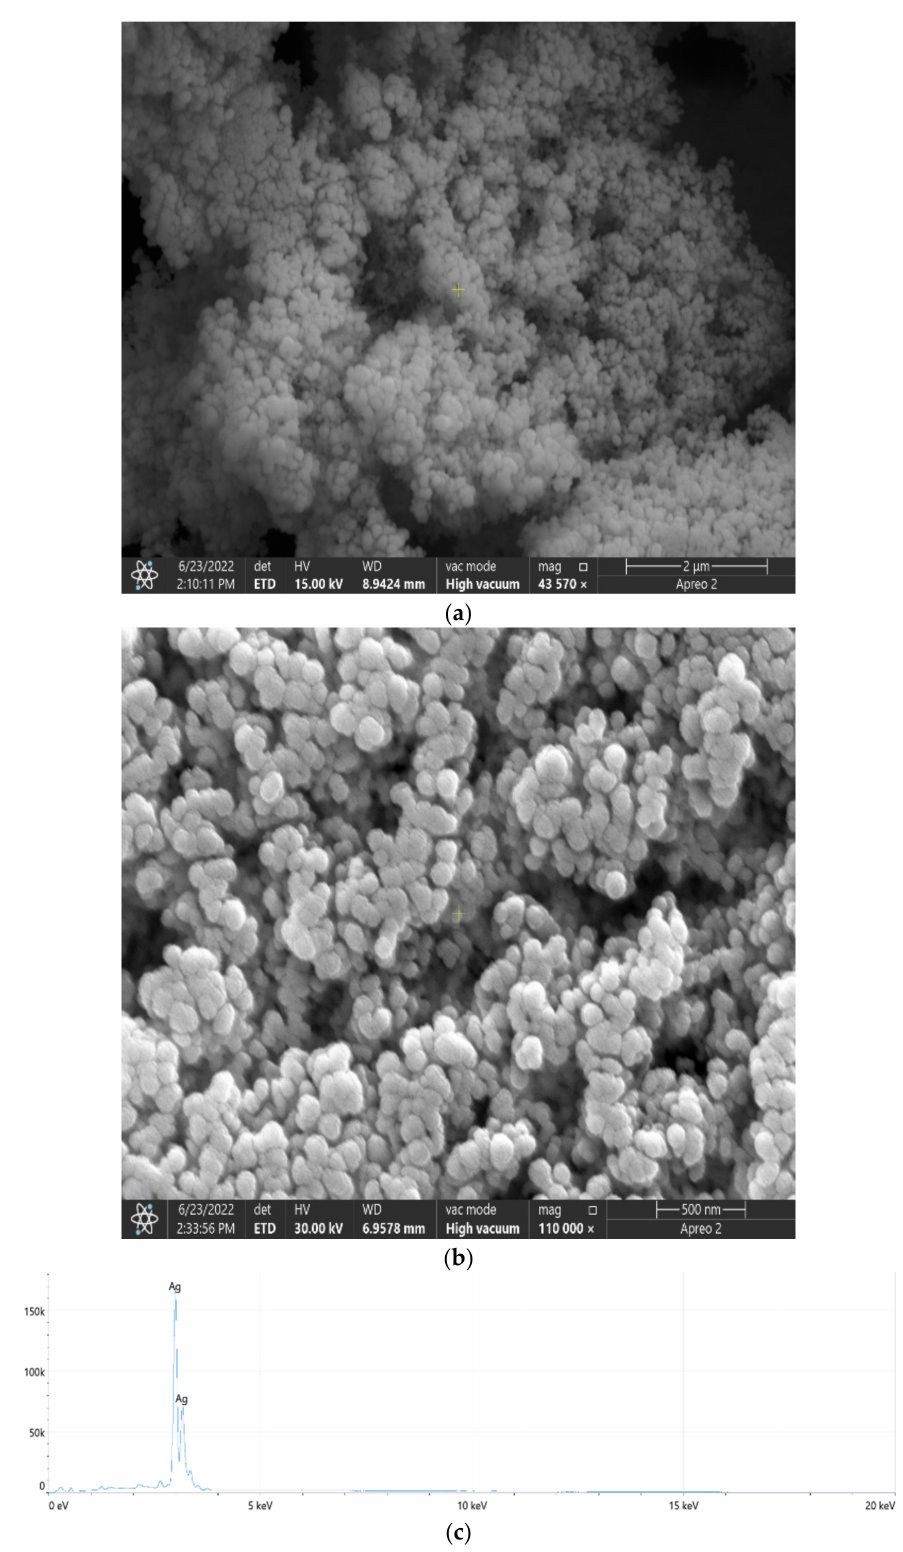
Figure 8. SEM ( a , b ) and EDX images ( c ) of synthesized silver